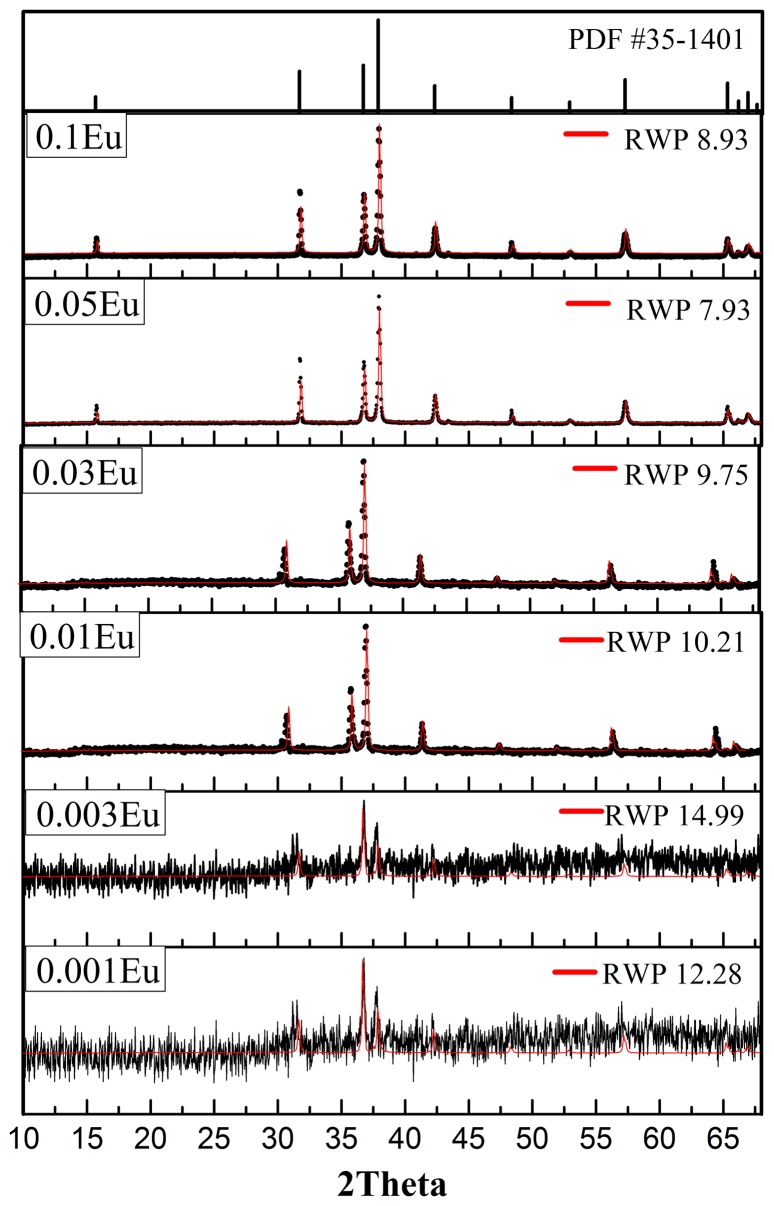
XRD patterns and profile fitting of CuAl1-xEuxO2 (x=0.001, 0.003, 0.01, 0.03, 0.05, 0.1) electrospun fibers annealed at 1100 °C for 3 h, with standard PDF#35-1041 corresponding to 3R-polytype delafossite CuAlO2.